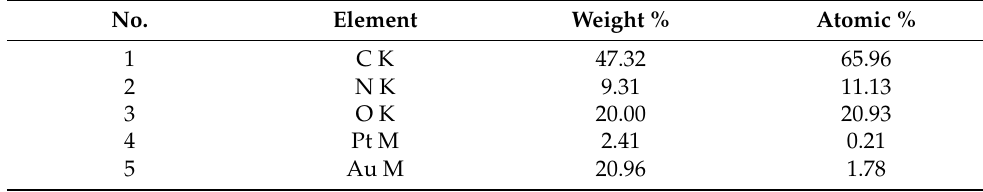
Table 1. EDS data of PtNPs.